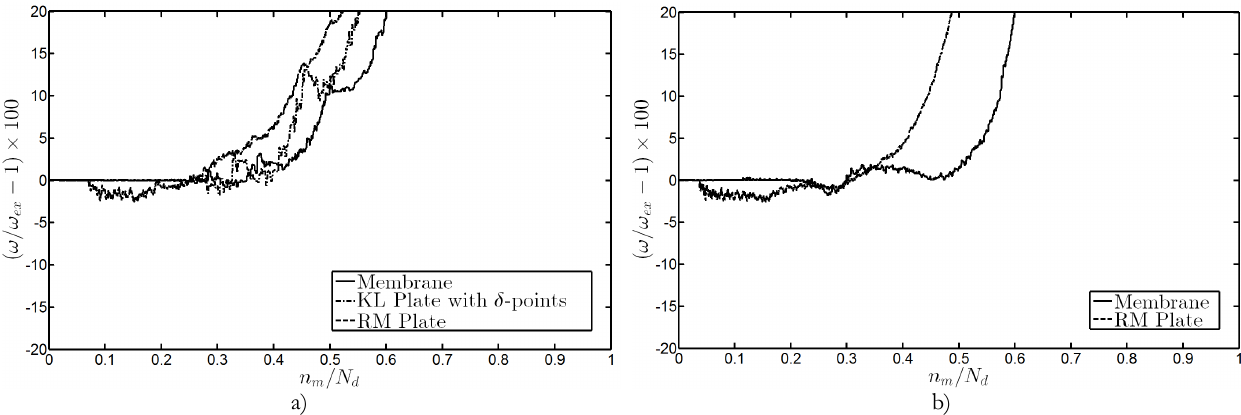
Figure 7: a) Dynamic discrete spectra for single element structural components with 31 N  for a Membrane, a KL plate with  - points ( 5 10  ) and a RM plate using PDQ basis functions and Che-Gau-Lob grid distribution. b) Dynamic discrete spectra for various n  for a Membrane and a RM plate using PDQ basis functions and Leg-Gau grid structural components with 7 N  and 64 e